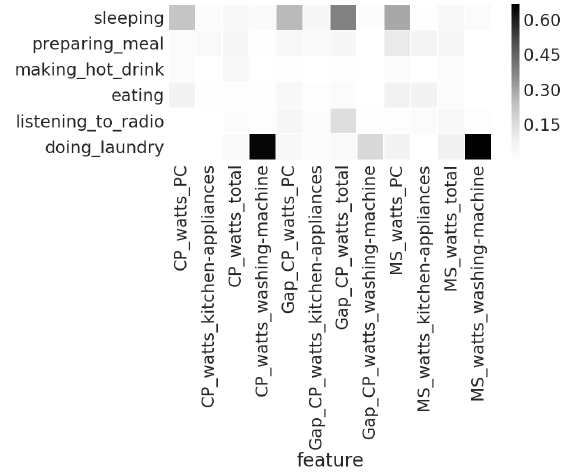
Figure 10. Correlations between the activities recorded by the occupant from Household 3 and the features of electricity